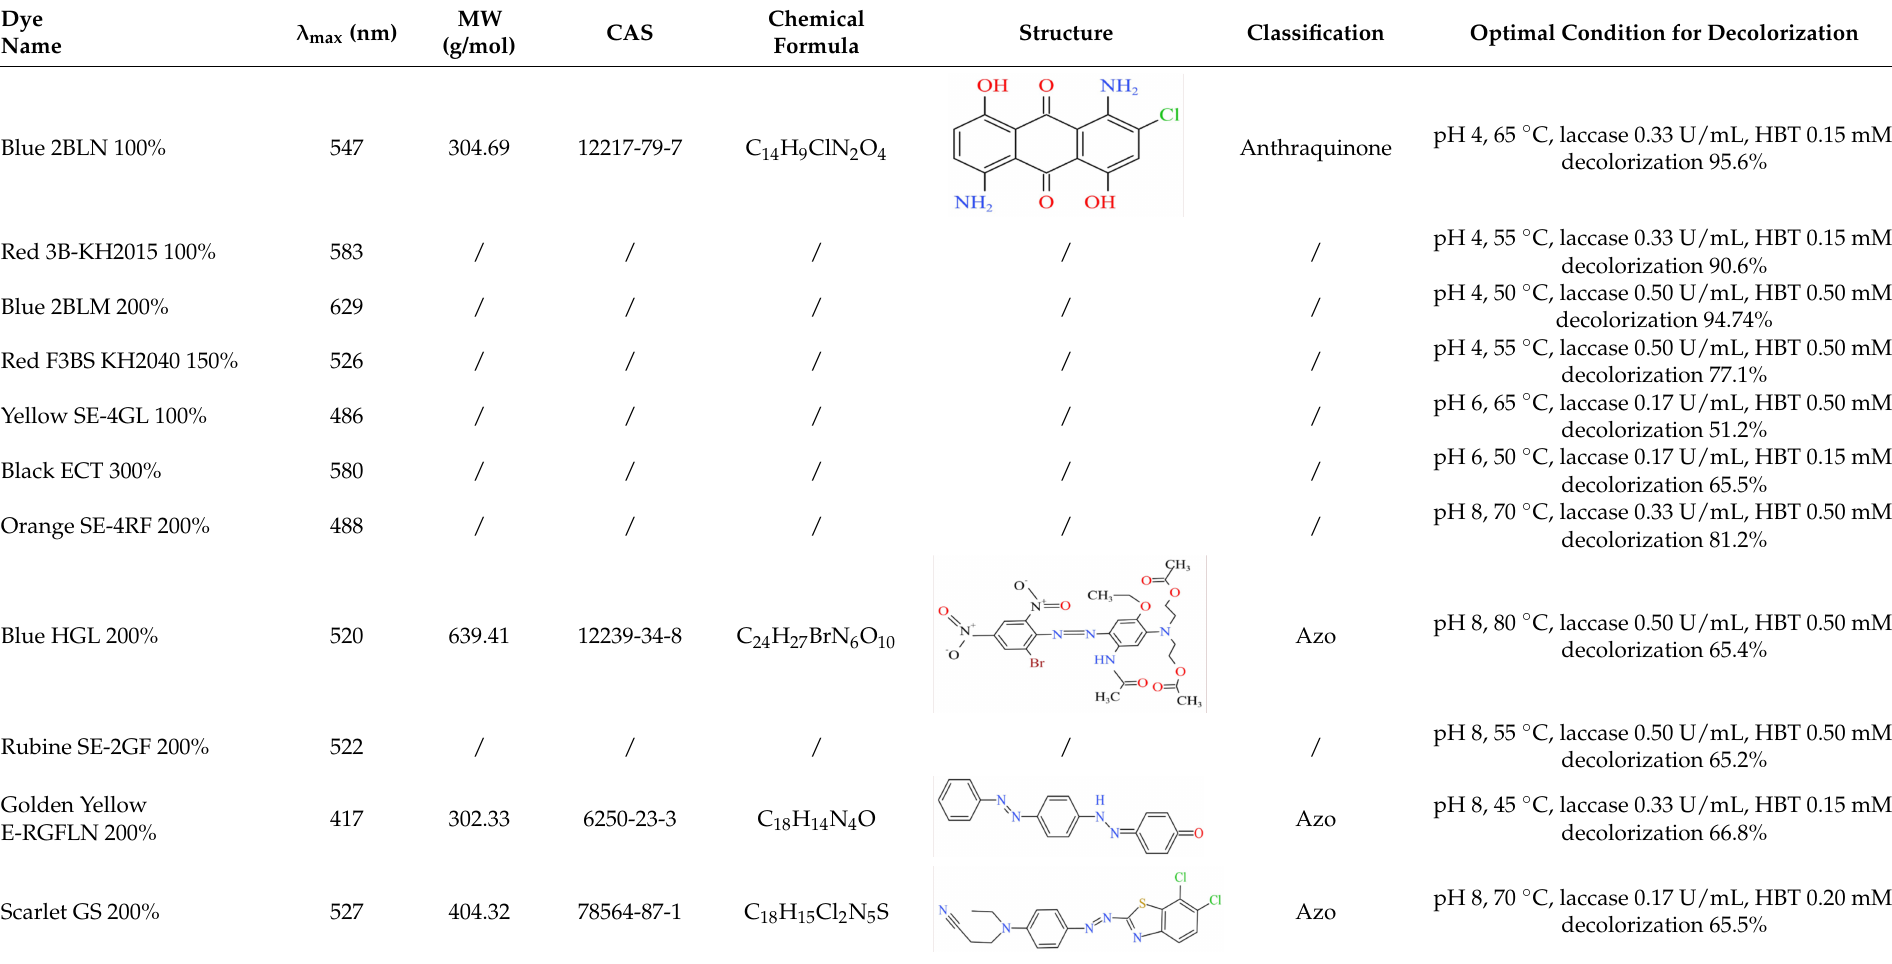
Table 1. Description of 11 disperse dyes from a textile factory. ‘/’ means currently unknown in this